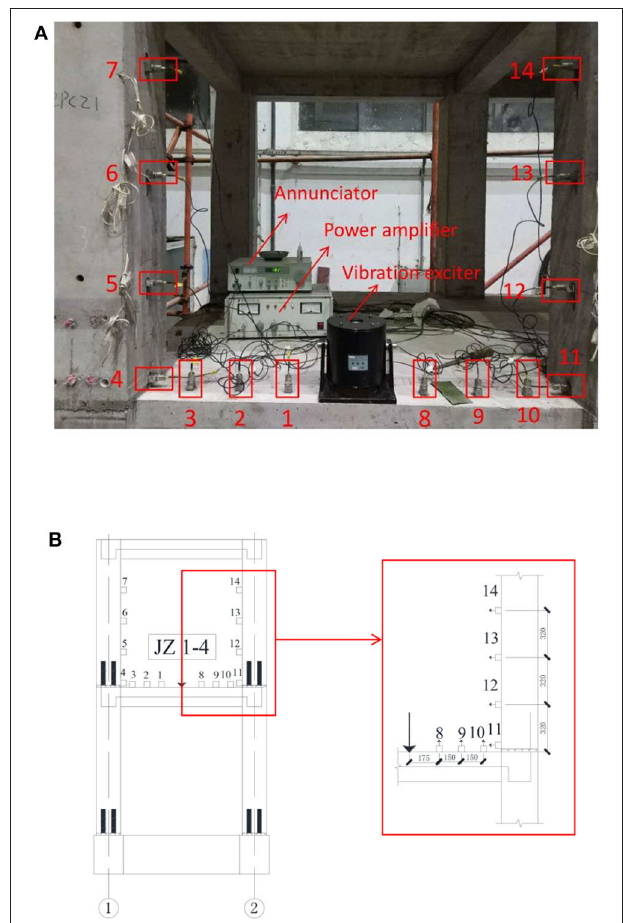
FIGURE 10 | Arrangement of the excitation points and measuring points. (A) Physical diagram. (B) Schematic